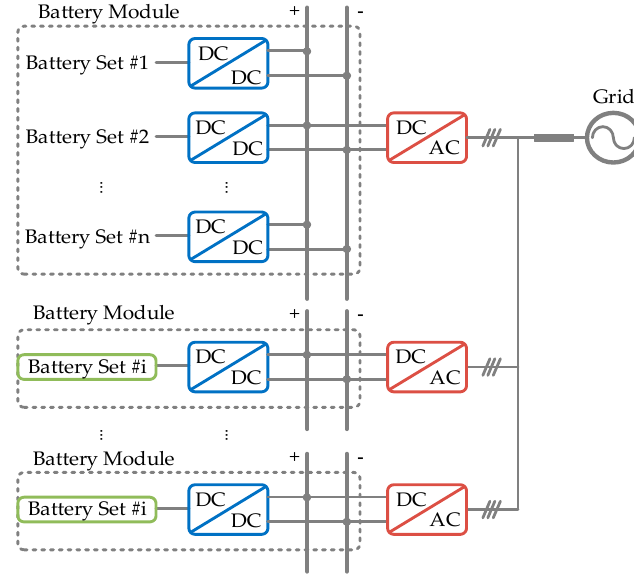
Figure 1. Configuration of the two-stage battery energy storage system (BESS).